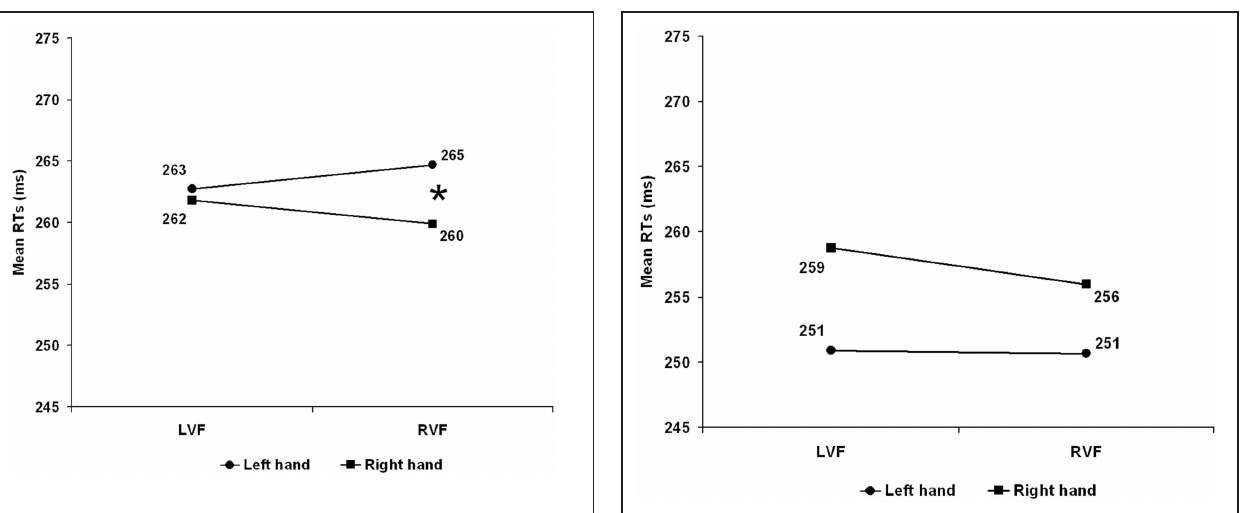
(2.2%), responses faster than 120 ms (0.8%) and slower than 700 ms (0.2%) were discarded. Correct RTs were submitted to the same mixed ANOVA as in Experiment 1.